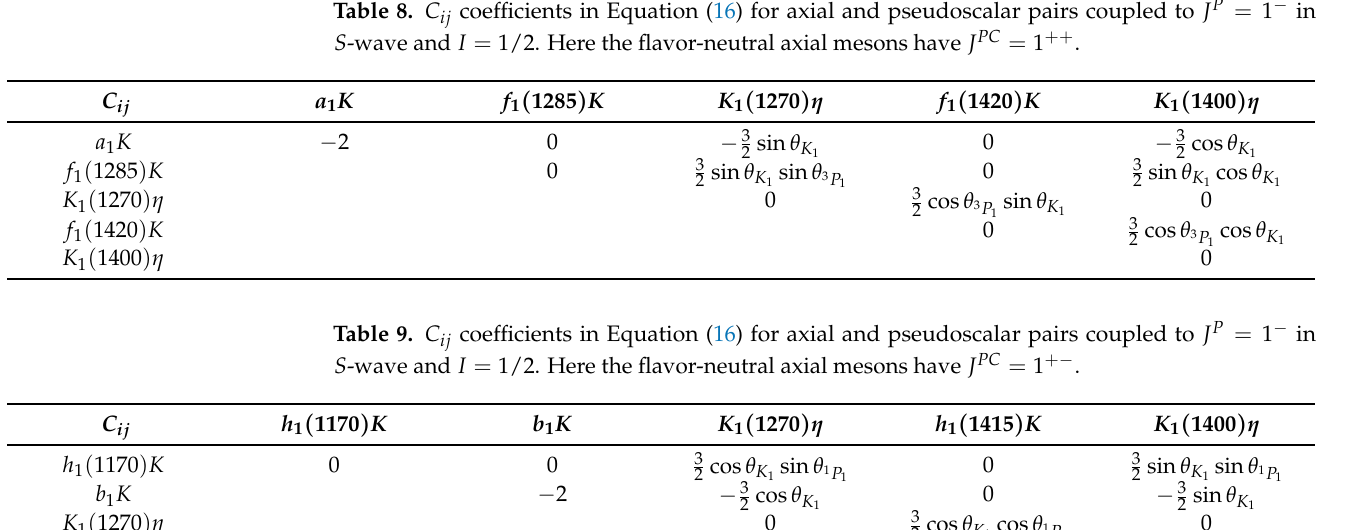
Table 8. C ij coefficients in Equation (16) for axial and pseudoscalar pairs coupled to J P = 1 − in